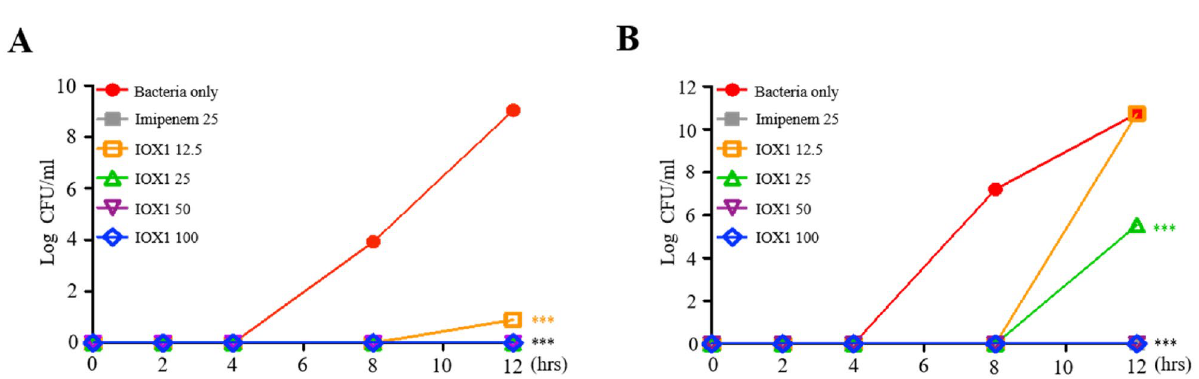
Figure 5. IOX1 antibiotic effect on gram-negative bacteria. ( A ) Bactericidal kinetics of IOX1 against susceptible DH5a (4.03 × 10 4 CFU/ml) and ( B ) A. baumannii KUMC.2015.sus (4.3 × 10 4